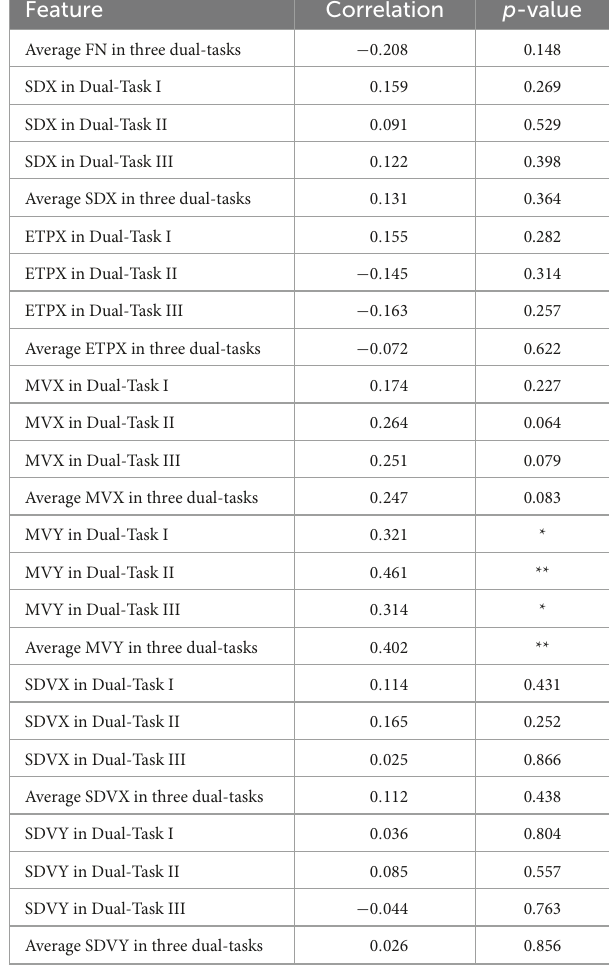
TABLE 2 Correlation analysis of features and cognitive test